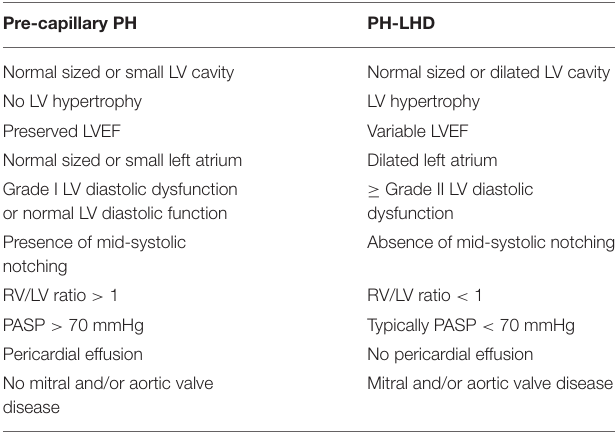
TABLE 2 | Echocardiographic features likely to be present in pre- and post-capillary pulmonary